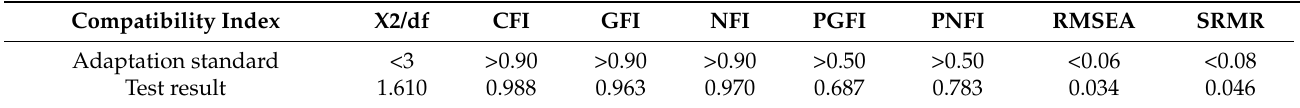
Table 7. Model fit test.